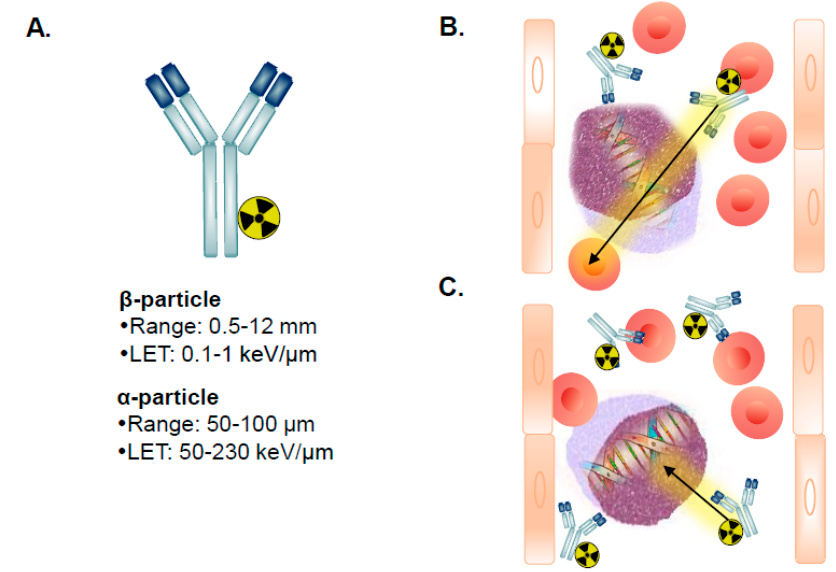
Figure 2. Radioimmunotherapy for acute myeloid leukemia. Illustration of ( A ) a mAb radiolabeled with either a ( B ) β -particle or ( C ) α -particle-emitting radionuclide and the track of the particles perfusing the bone marrow to target AML cells. Note that the path length of β -particles is greater than for α -particles leading to β -particle-based RIT used primarily in preparative regimens to myeloablate the bone marrow prior to hematopoietic cell transplantation.